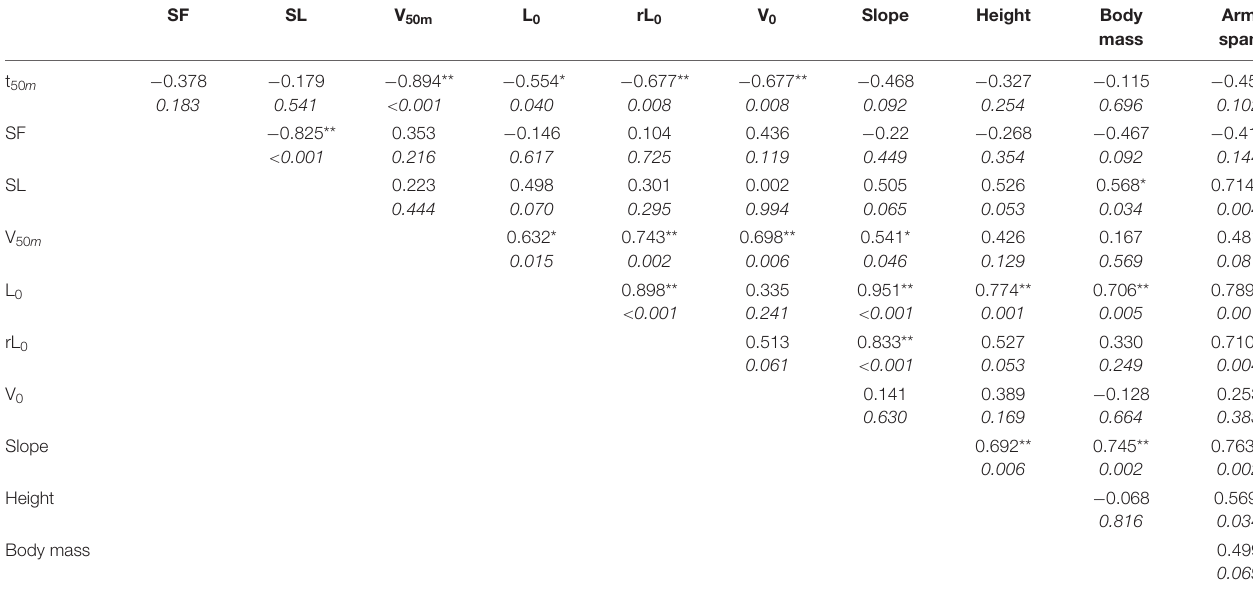
Numbers in plain font and italics show correlation coefficients and p-value, respectively. t 50m = time for the 50 m front crawl; SF = stroke frequency for the 50 m front crawl; SL = stroke length for the 50 m front crawl; V 50m = mean free-swimming velocity during 50 m front crawl; L 0 = estimated maximum load from the load-velocity slope; rL 0 = estimated maximum load as a percentage of body mass; V 0 = estimated maximum velocity from the load-velocity slope; Slope = steepness of load-velocity regression; *p < 0.05; **p < 0.01.